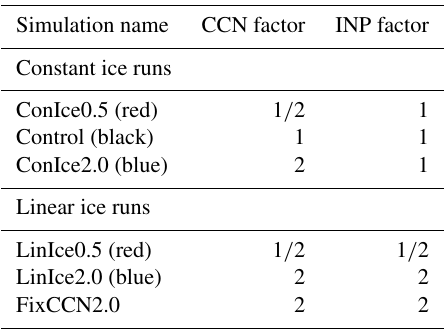
Table 1. Description of simulations completed and discussed in the